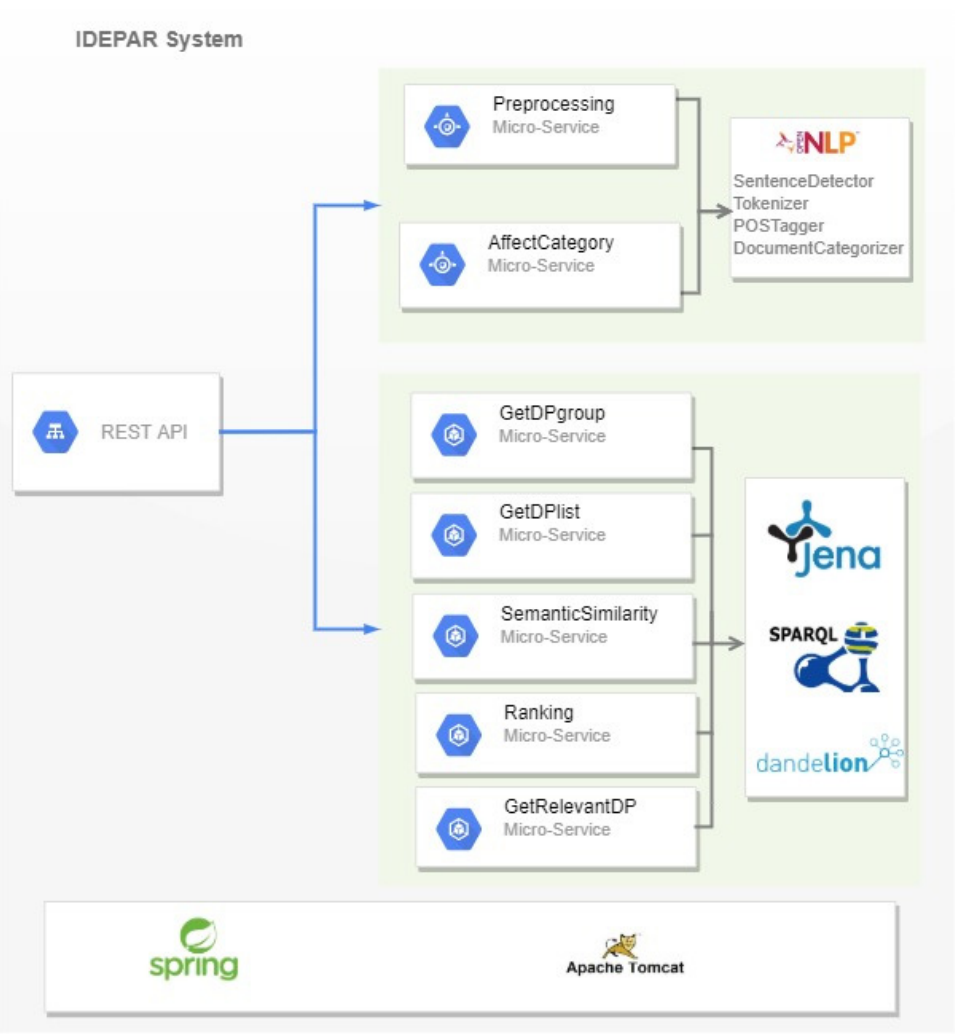
Figure 7. IDEPAR system—server-side implementation.